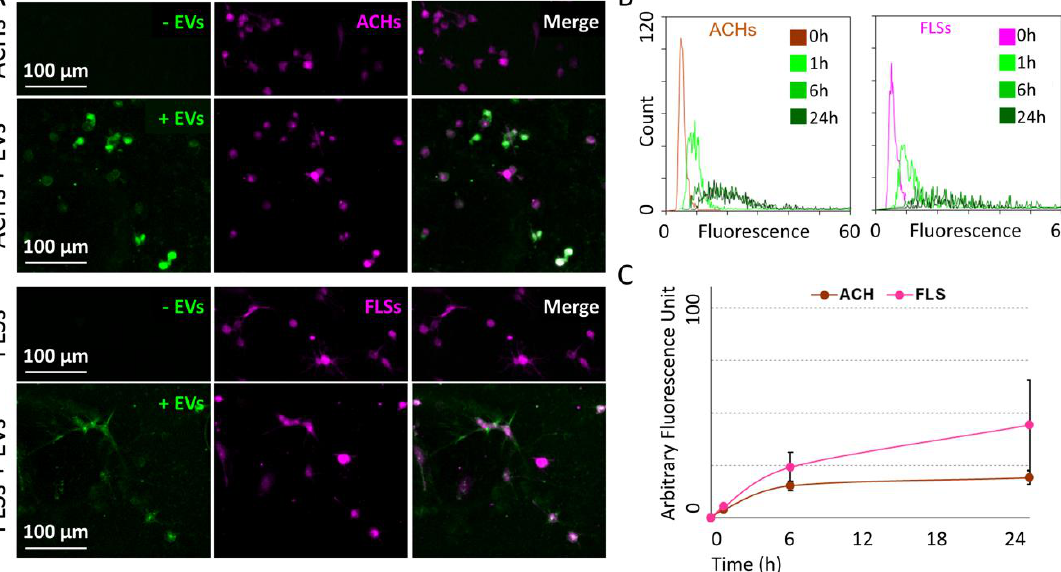
Figure 5. ASC-EV interaction with and incorporation in ACHs and FLSs over time in 3D microfluidic devices. ( A ) Pictures at time 0 and after 24 h of ACHs and FLSs grown in 3D chips and incubated with ASC-EVs. EVs were CFSE-stained and are shown in green, whereas cells were stained with CellTracker™ Deep Red Dye and are shown in violet. The merged pictures clearly show the overlapping of the signal of ASC-EVs with cells. One representative donor is shown. ( B ) Green fluorescence intensity at different time points of ACHs and FLSs incubated or not with ASC-EVs inside the 3D microfluidic device. ( C ) The trend over time of mean green fluorescence of ACHs and FLSs incubated with ASC-EVs. N = 3, values are shown as mean ± SE. Significance for p -value < 0.05. ( D ) Representative pictures of ASC-EVs (green) incubated with ACHs (violet) after 24 h in 3D microfluidic device. EVs clearly surrounded ACHs and were also internalized, as indicated in the merge pictures by the white arrows. (E) Trend over time of the number of cells either interacting with ASC-EVs regardless outside or inside (continuous line) or with internalization (dashed line). N = 3, values are shown as mean ± SE. Significance for p -value < 0.05. 3.4. Hyaluronic Acid Removal Affected ASC-EV Interaction with Cells in 2D but Not in 3D Cultures Cells treated with hyaluronidase and maintained in complete medium containing hyaluronan synthesis inhibitor 4-methylumbelliferone (4-MU) were co-incubated with EVs. Fluorescence was detected at 24 h with either flow cytometry for 2D cultures or confocal microscopy for 3D microfluidic devices. Flow cytometry confirmed the significant ( p -value < 0.05) reduction (42 ± 7 %) in fluorescence in FLSs (Figure 6A). The diminution was also observed in ACHs with a similar percentage (47 ± 1%) (Figure 6B).